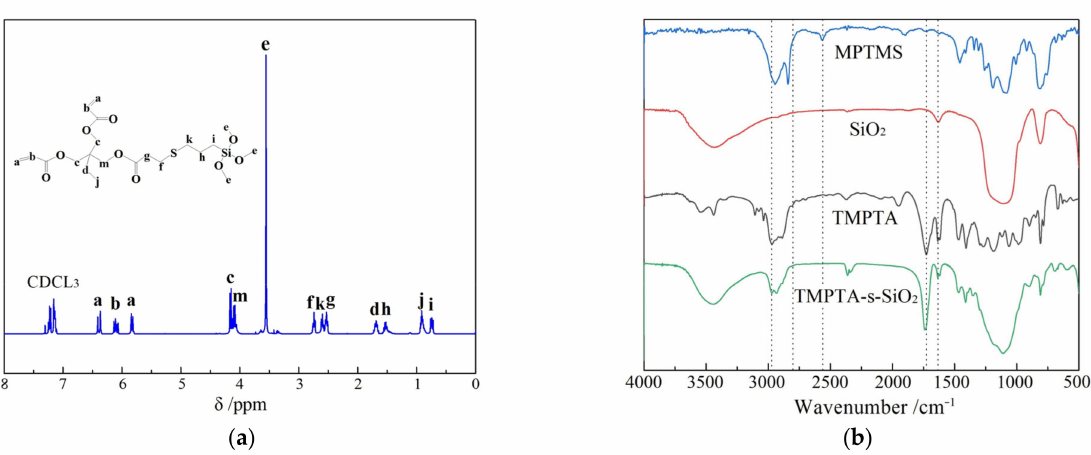
Figure 2. ( a ) 1 H-NMR spectrum of MTMPTA molecules and ( b ) Fourier transform infrared (FTIR) transmission spectra of MPTMS, neat nanosilica, TMPTA, and TMPTA- s -SiO 2